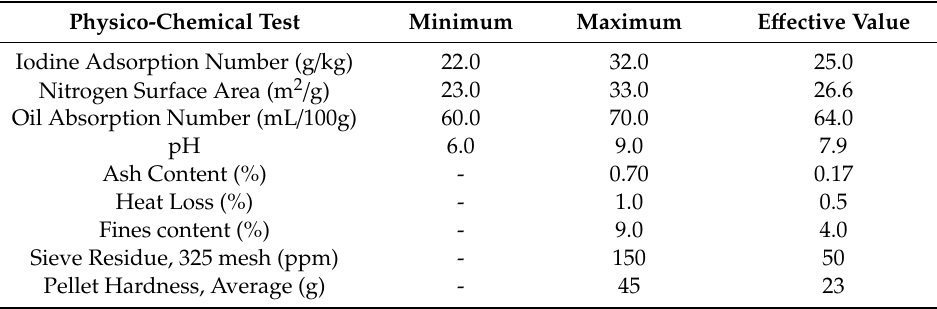
Table 11. Characteristics of carbon furnace black CB Tokai ®